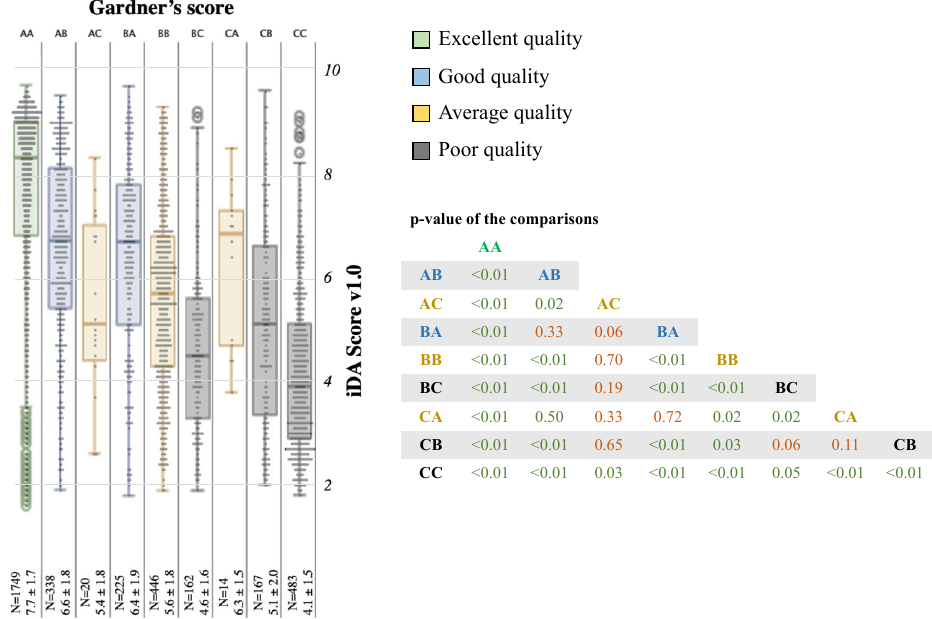
Figure 4. iDAScore v1.0 is associated with overall blastocyst quality. A, B, and C (from best to worst quality) outline inner cell mass (the first letter) and trophectoderm (the second letter) quality as defined by the embryologists according to the Gardner’s score. Overall blastocyst quality is defined as excellent (AA, green), good (AB and BA, blue), average (AC, CA, and BB, gold), or poor (BC, CB, and CC, grey) according to Gardner’s score adapted by Capalbo et al. [13]. The table summarizes the p -values of each sub-group